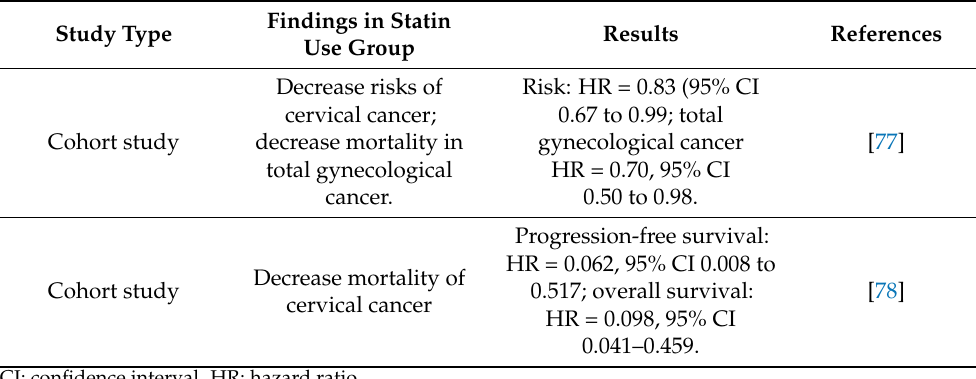
Table 4. Clinical studies of statins in other gynecological